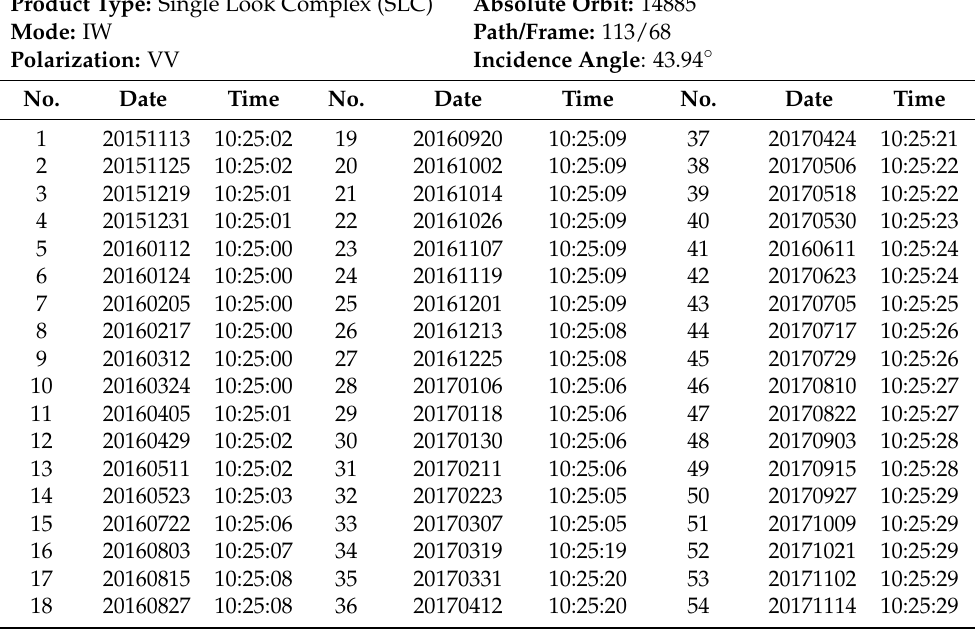
Table 2. Basic information and list of ascending Sentinel-1A Dataset II in LJP. The master image for PS and DS processing is